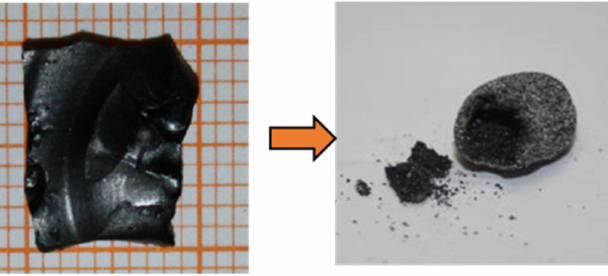
Figure 16. Formation of carbon-sand aggregates with RW in fluidized bed (from [23] with